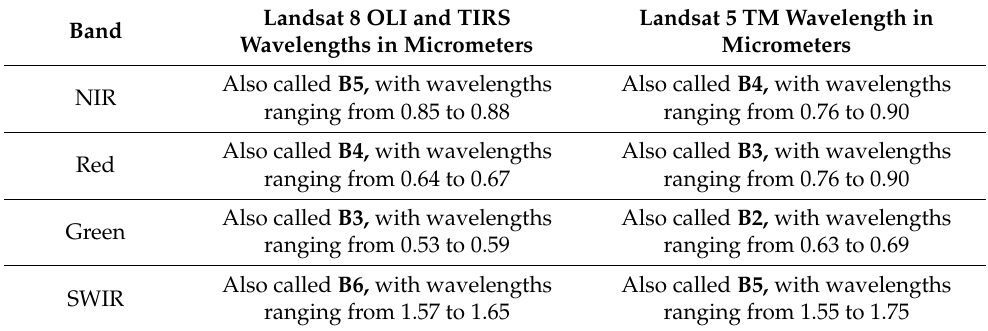
Figure 2. Study areas of located targeted cities used in the classification process. Table 2. List of dataset characteristics for urban